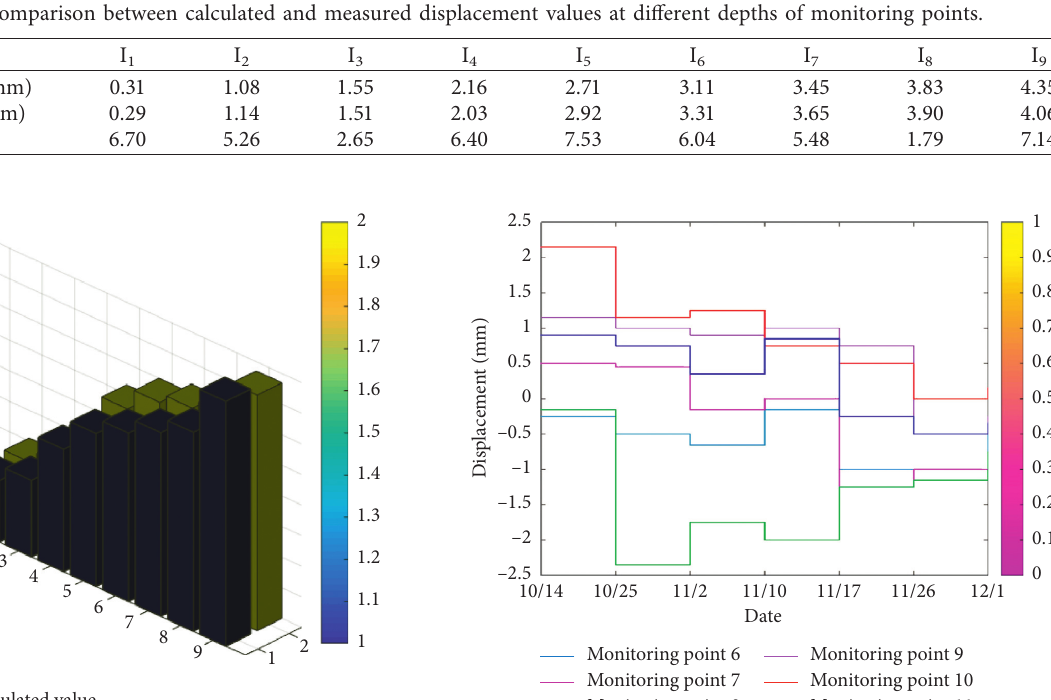
Figure 6: Analysis chart of comparison result between the cal- culated value and the measured value.